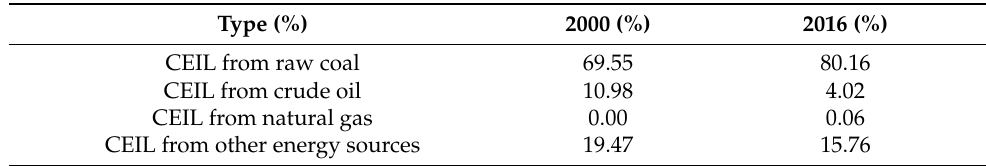
Table 2. The proportion of CEIL from the consumption of various types of fossil energy in Anhui Province in 2000 and 2016.